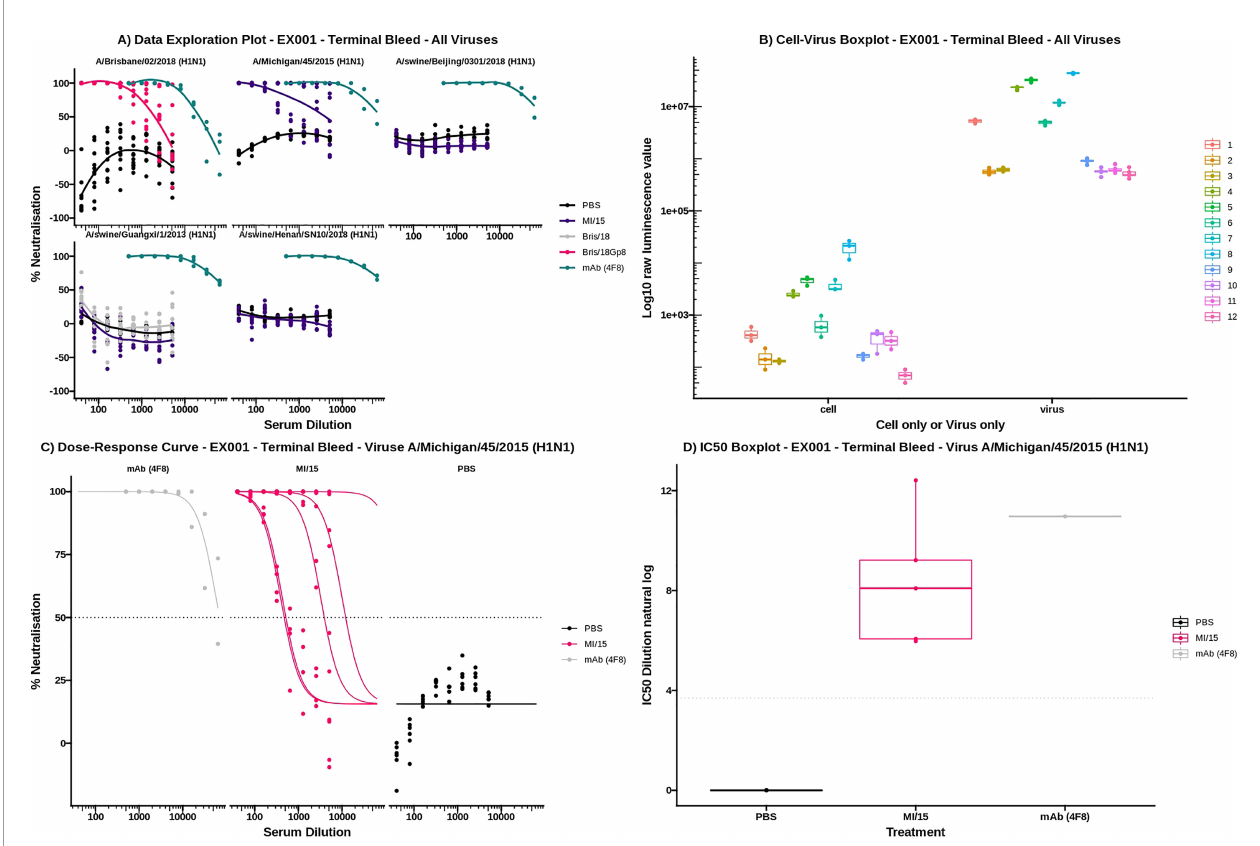
FIGURE 10 | AutoPlate Step 3) Results Plots Screenshot (A) Data Exploration Plot. For each virus the serum dilution is plotted on the x-axis against the neutralisation on the y-axis. Each line represents a different treatment group. (B) Virus Cell Boxplot. The graph shows cell and virus only well types on the x-axis for each plate plotted against the log raw luminescence value. (C) Dose-response Curves Plot. The plot for virus A/Michigan/45/2015 (H1N1) is shown with the serum dilution plotted on the x- axis against the neutralisation on the y-axis. Each line represents a single sample and is coloured by the treatment group. (D) IC 50 Boxplot. The plot for virus A/Michigan/ 45/2015 (H1N1) is shown with the log IC 50 dilution plotted on the x-axis against the treatment group on the y-axis. Each data point represents a single